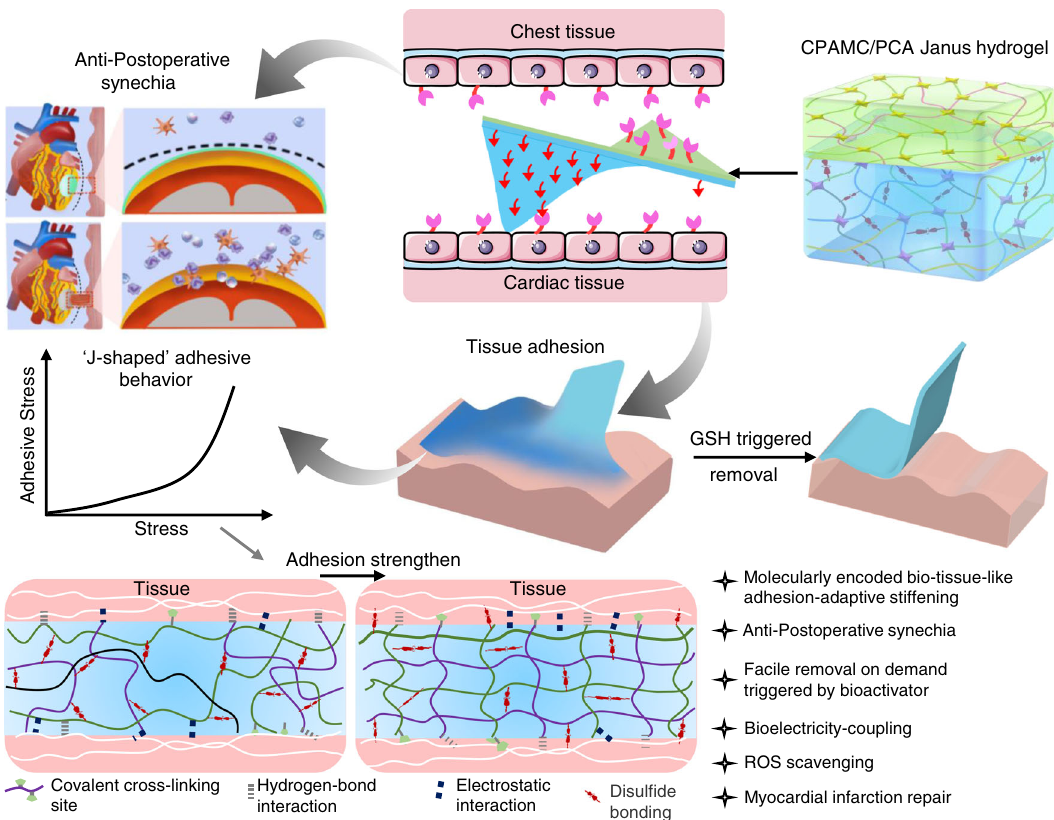
Fig. 1 | Schematic illustration of the smart Janus adhesive and on-demand removable CPAMC/PCA hydrogel as a multifunctional engineered cardiac tis- sue patch (ECP) to repair rat ’ s myocardial infarction (MI). The Janus CPAMC/ PCA hydrogel can quickly adhere to the wet heart tissue and enable on-demand stimuli-triggered detachment, and simultaneously prevent post-tissue synechia. CPAMC hydrogels have greatly improved their adhesion properties through interpenetrated network containing multiplex covalent and non-covalent interac- tions, and interlaced interpenetration and physical entanglement of macro-